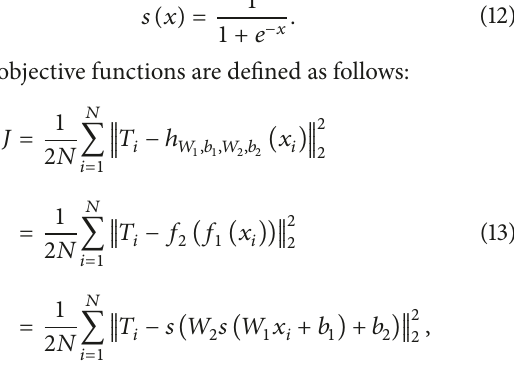
restrict 𝐻 to be equal to 𝐿 and experimented with hidden layer sizes that range from 50 to 500 in Section